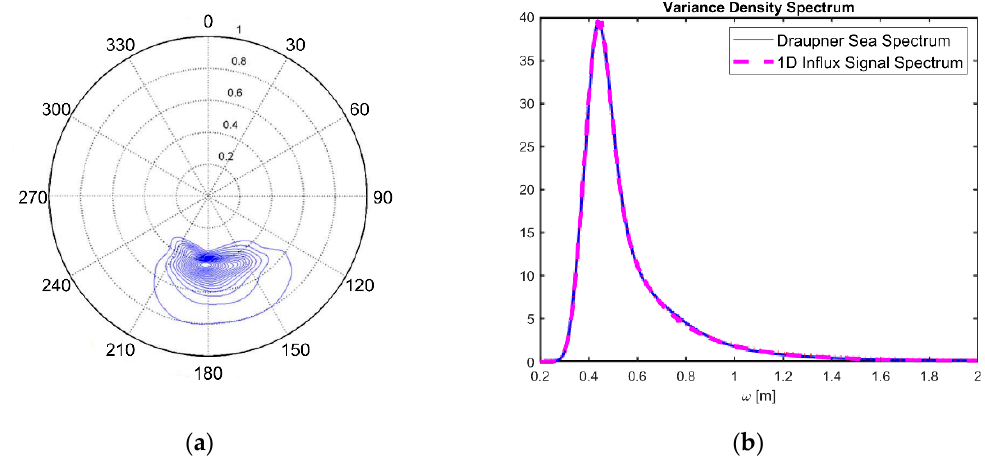
Figure 17. The directional spectrum of the “Draupner sea”, rotated with the main energy directed to the south [6] ( a ), and the corresponding 1D long-crested wave spectrum ( b ).